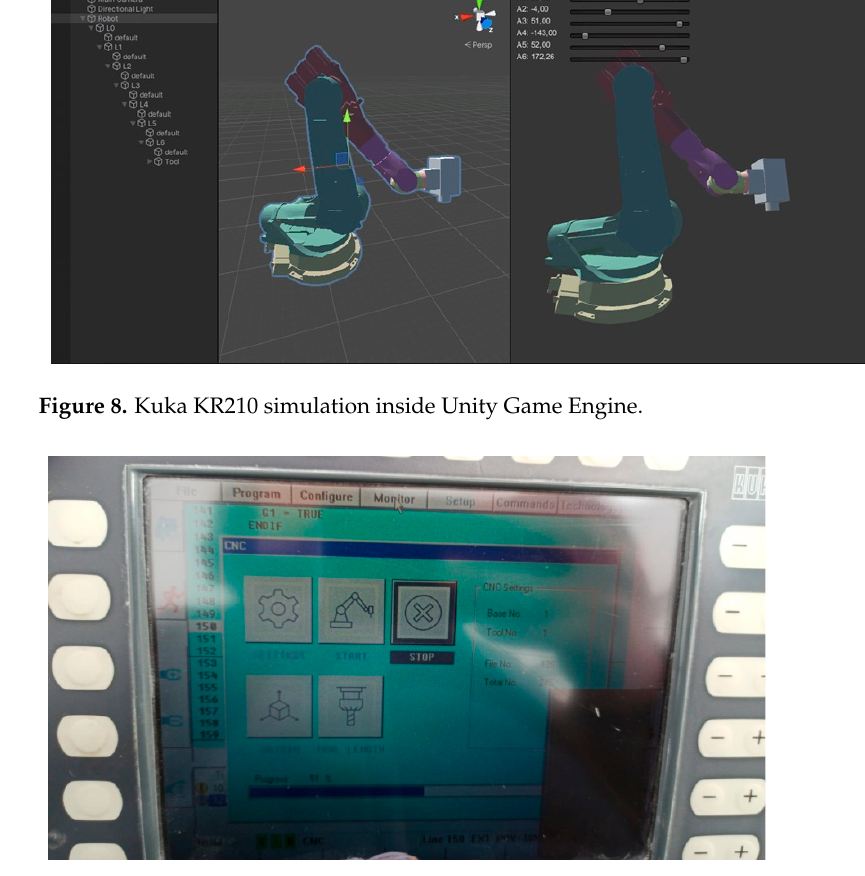
Figure 8. Kuka KR210 simulation inside Unity Game Engine.